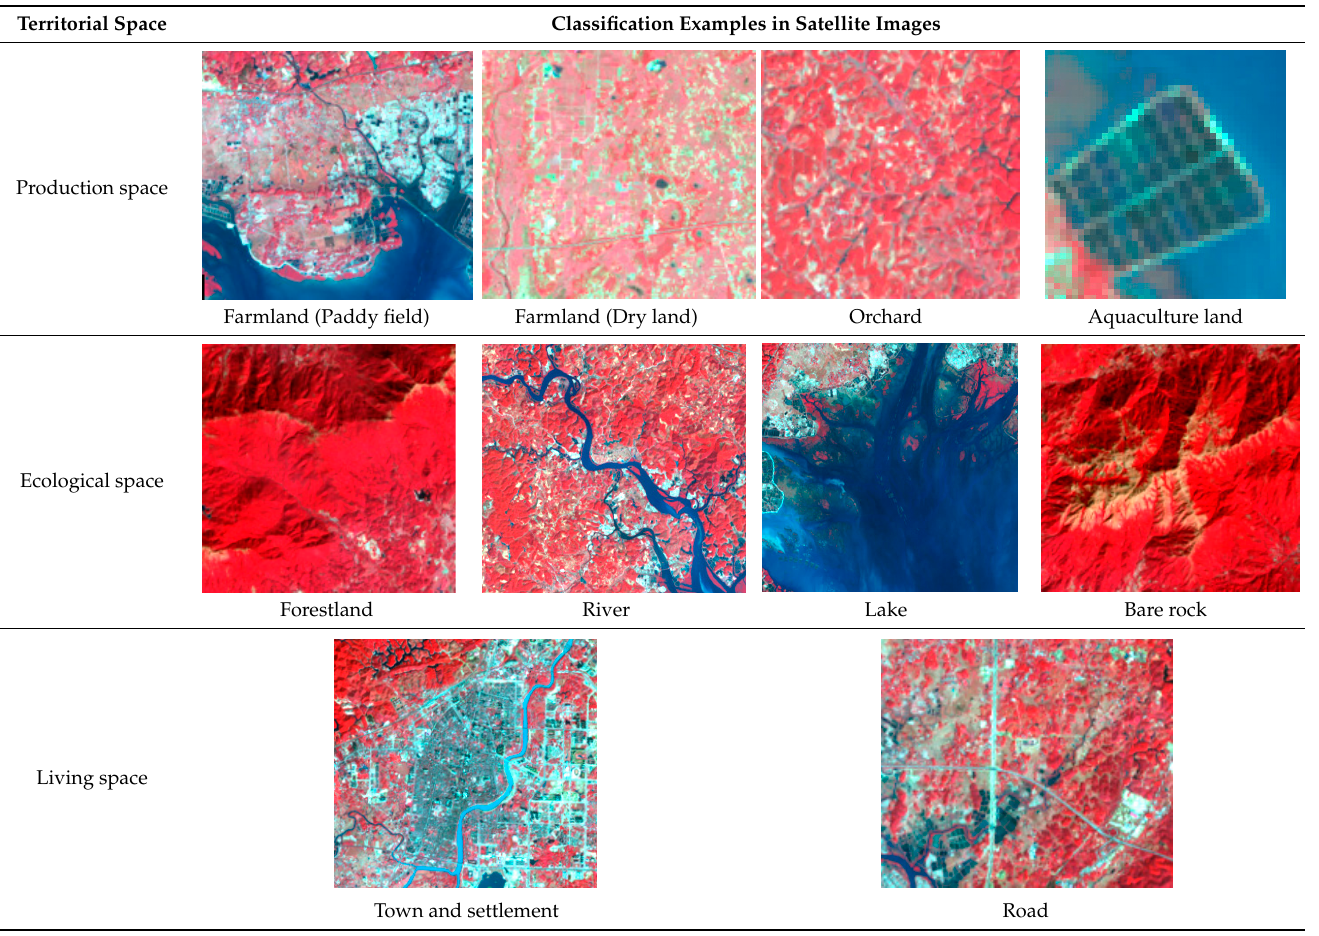
Table 2. Land-use types and classification examples in remote sensing images for three territorial spaces.